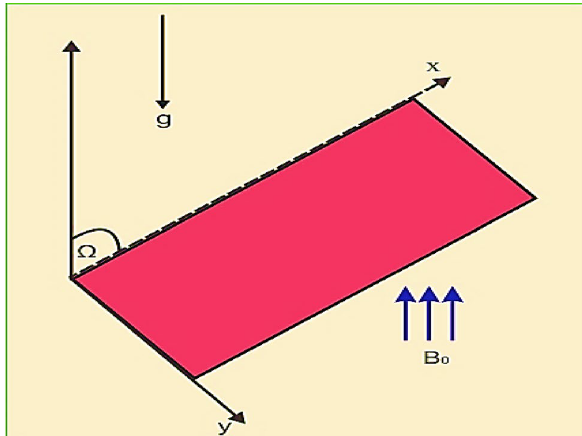
Figure 1. Physical sketch of model